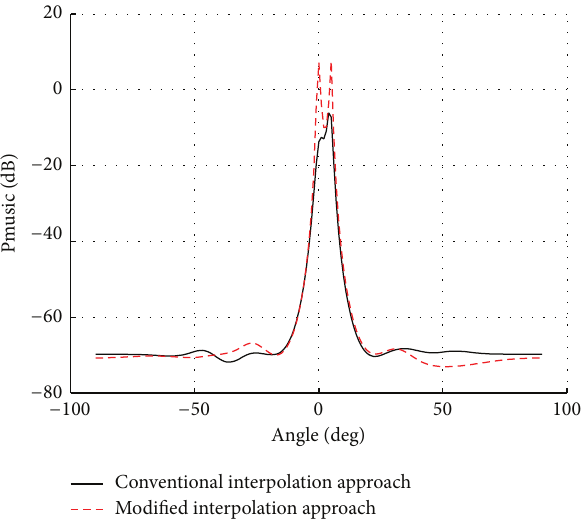
Figure 5: Spatial spectrum of MUSIC algorithm for two methods comparison.